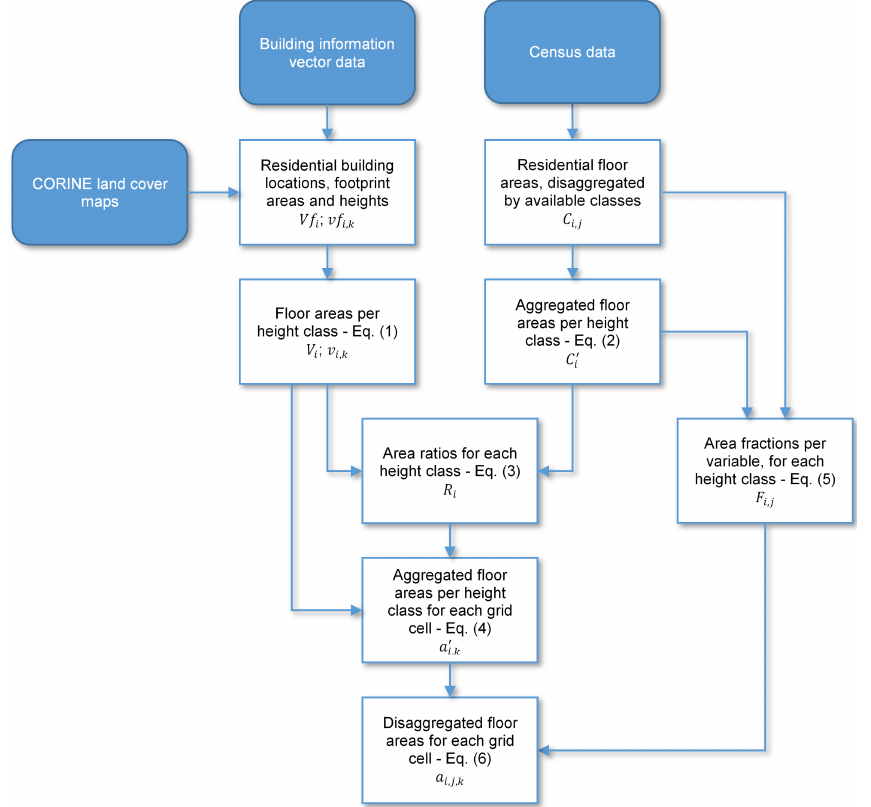
Figure 6. Flowchart of the method.